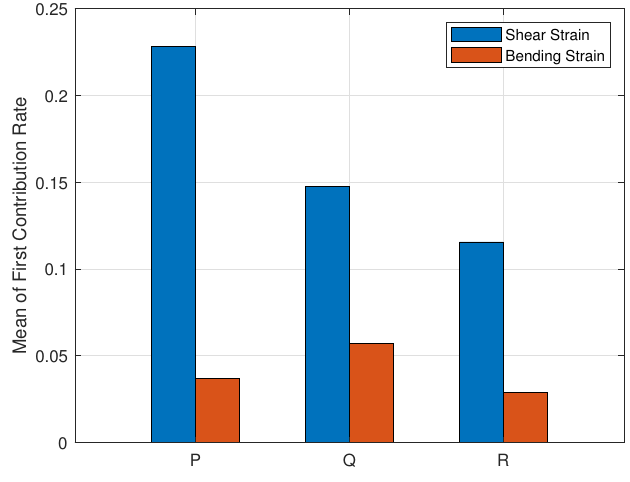
Figure 9. Averaged first contribution rates of wing rotation rates for all sensors.